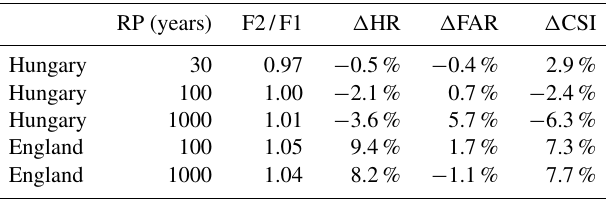
Table 8. Comparison of performances of the flood hazard maps described in the present study and developed by Dottori et al. (2016b). Table reports the ratio between flood extents (F2/F1) and the difference between version 2 and 1 of the HR, FAR and CSI